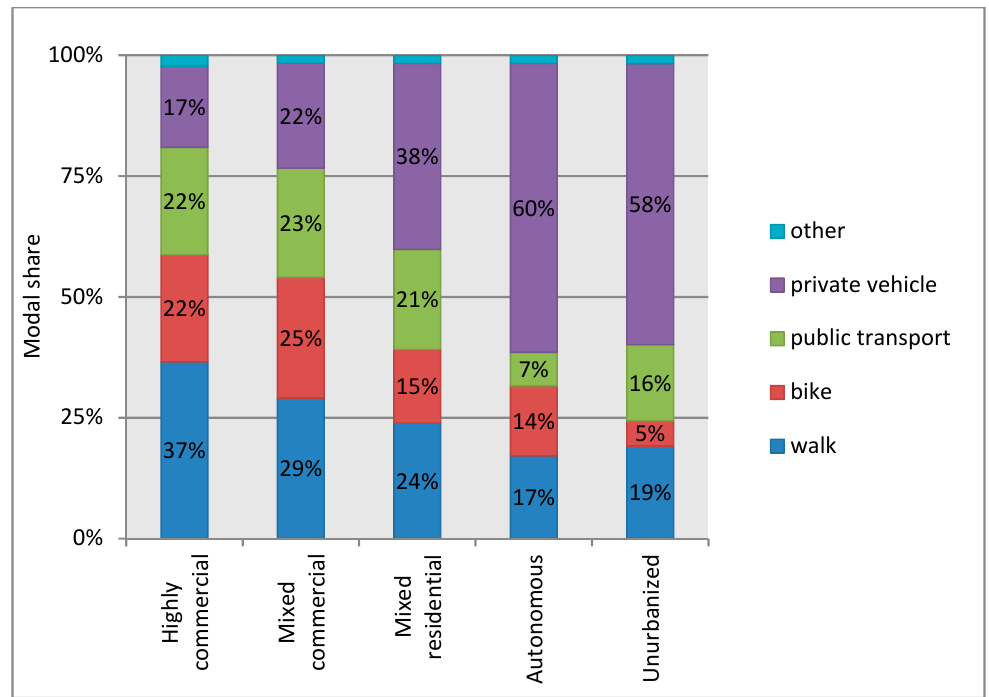
Figure 4. Modal share by built environment type.